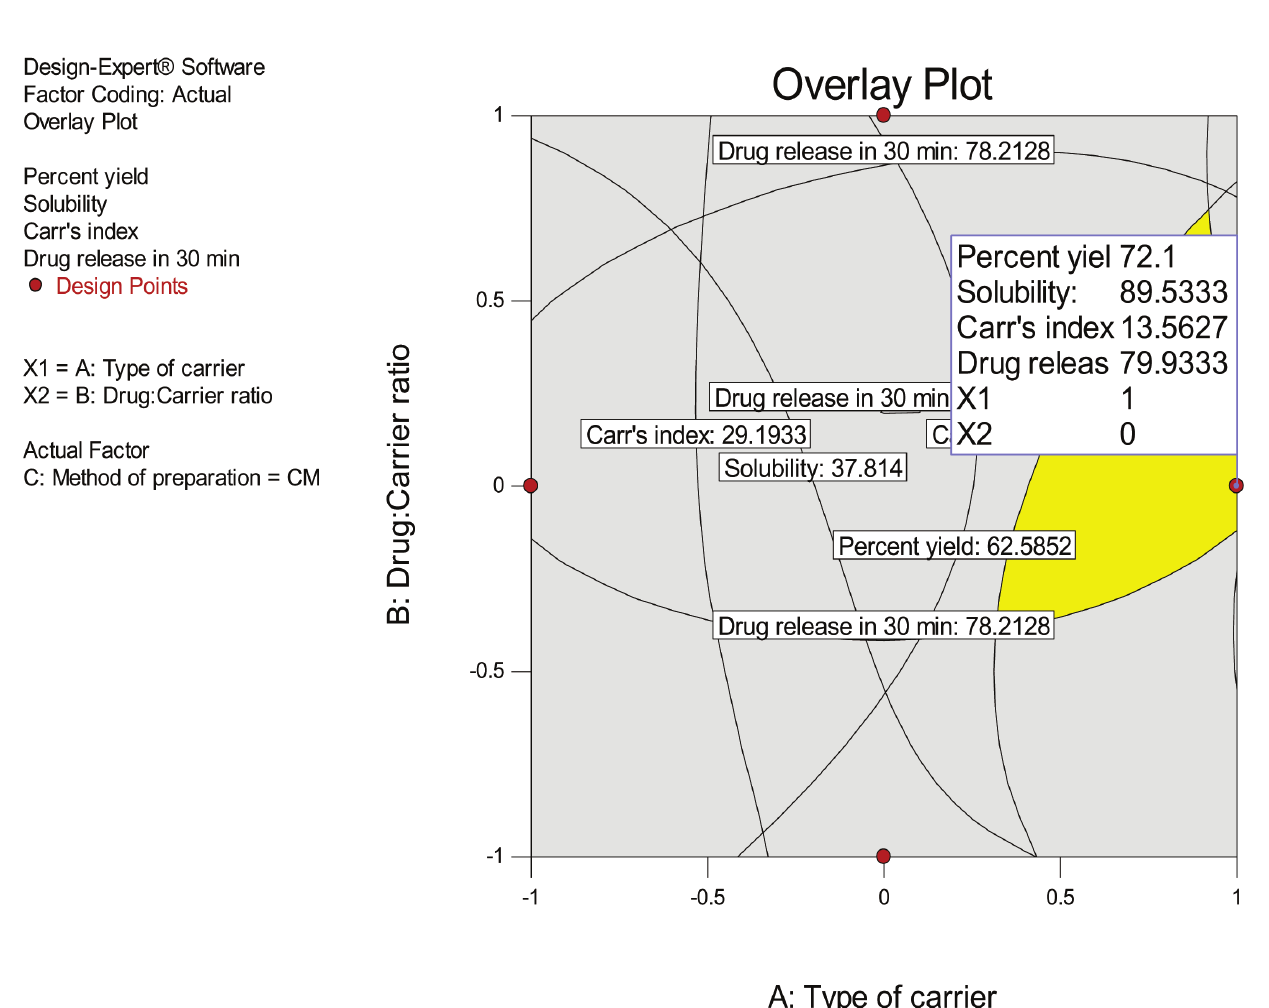
FIGURE 5 - Design space overlay plot indicating yellow color region as the design